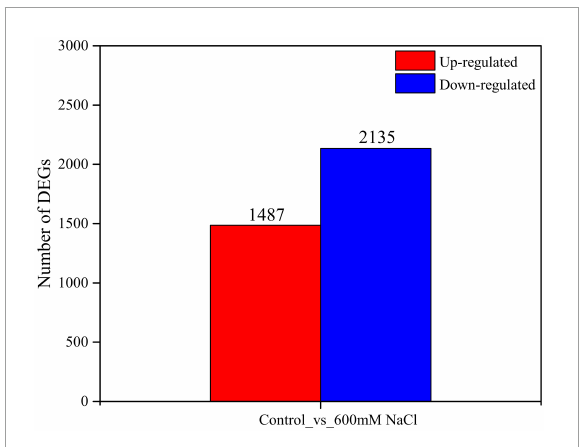
FIGURE4 The number of DEGs in the leaves of S. portulacastrum under high